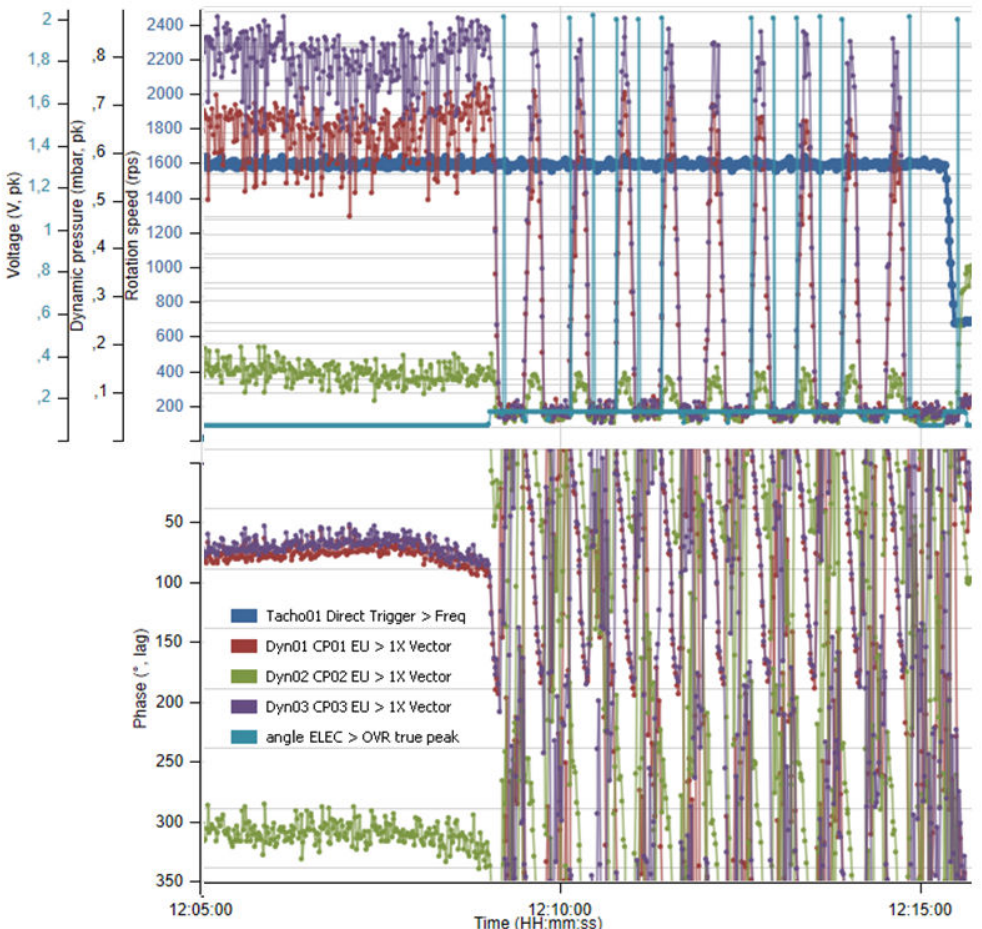
Figure 16. Excitation of the flame at 1604 Hz, where a resonance was observed with combustion. The first part is a continuous excitation; the second part is a sensitivity analysis with variable amplitude. The top plot reports the peak amplitudes of the fast pressure transducers. The lower plot reports the phase shift measured at this frequency versus the reference signal of the